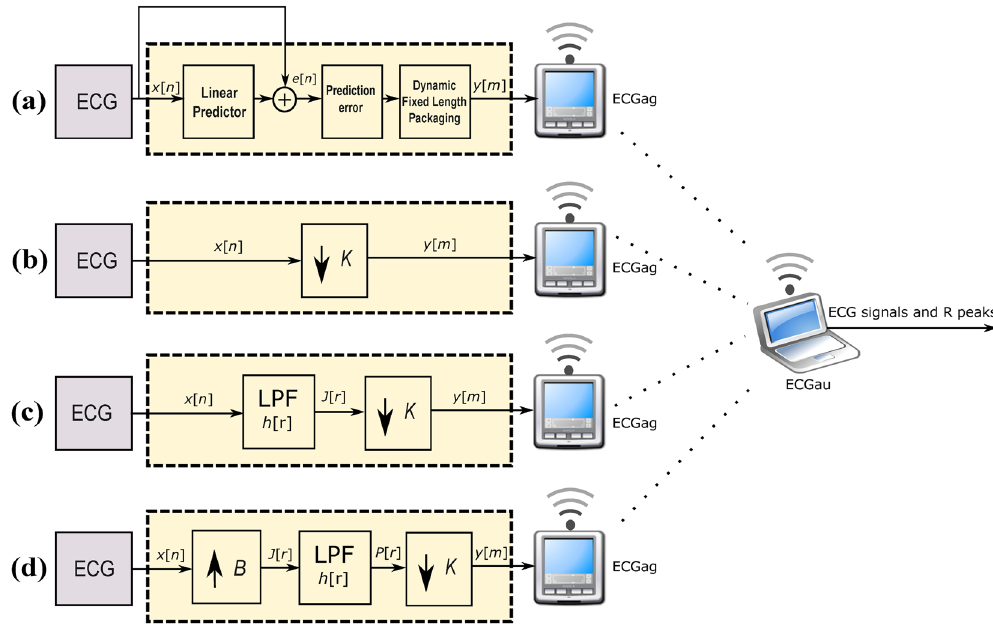
Figure 7. Compression methods. ( a ) Lossless Method I ( b ) Lossy Method II ( c ) Lossy Method III Here, ECGag stands for ECG data aggregators (e.g., mobile phones and point-of-care devices that have limited computational resources that collect the ECG signal) while ECGau stands for ECG analysis unit (e.g. a device with high computational resources such as a